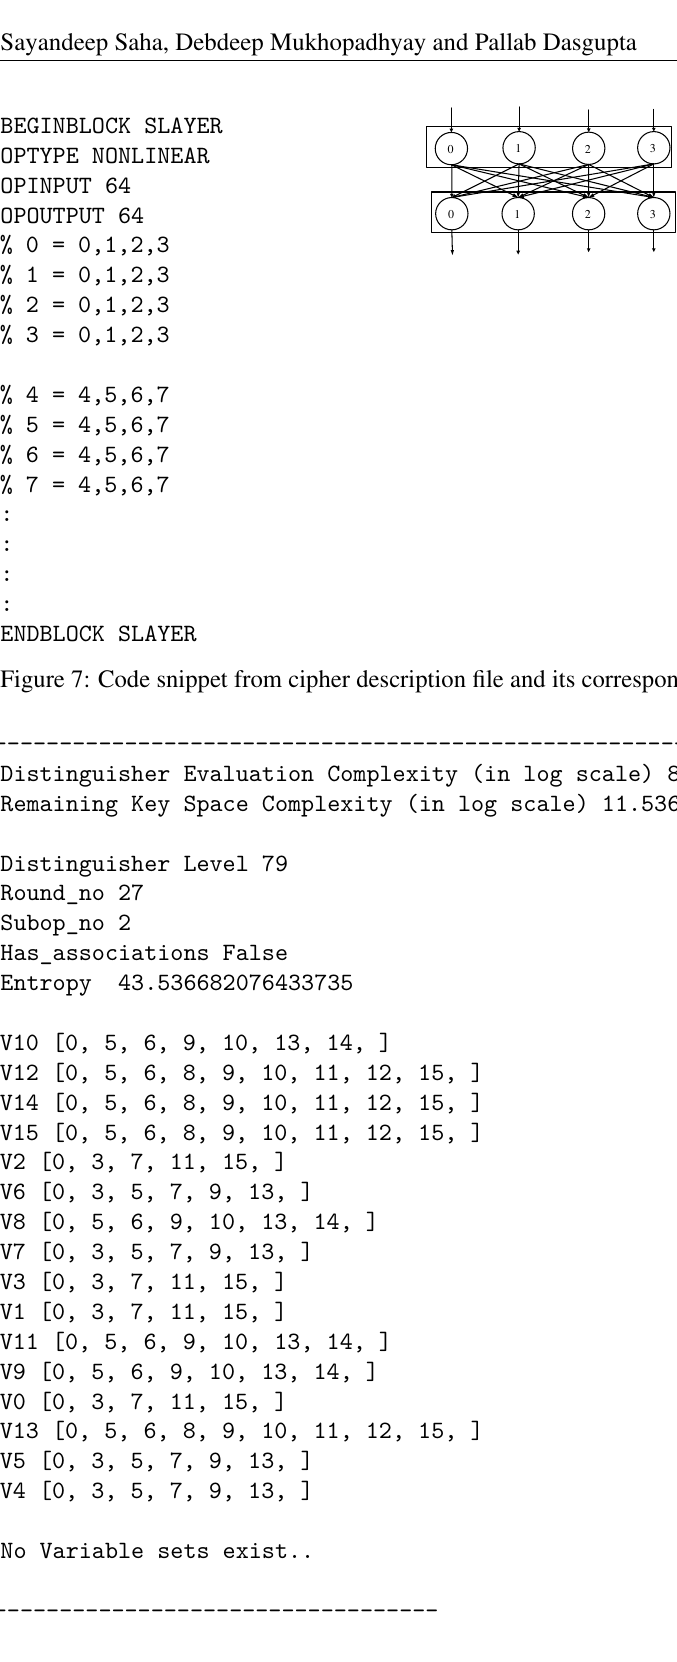
Figure 8: Description of a ditinguisher from the output